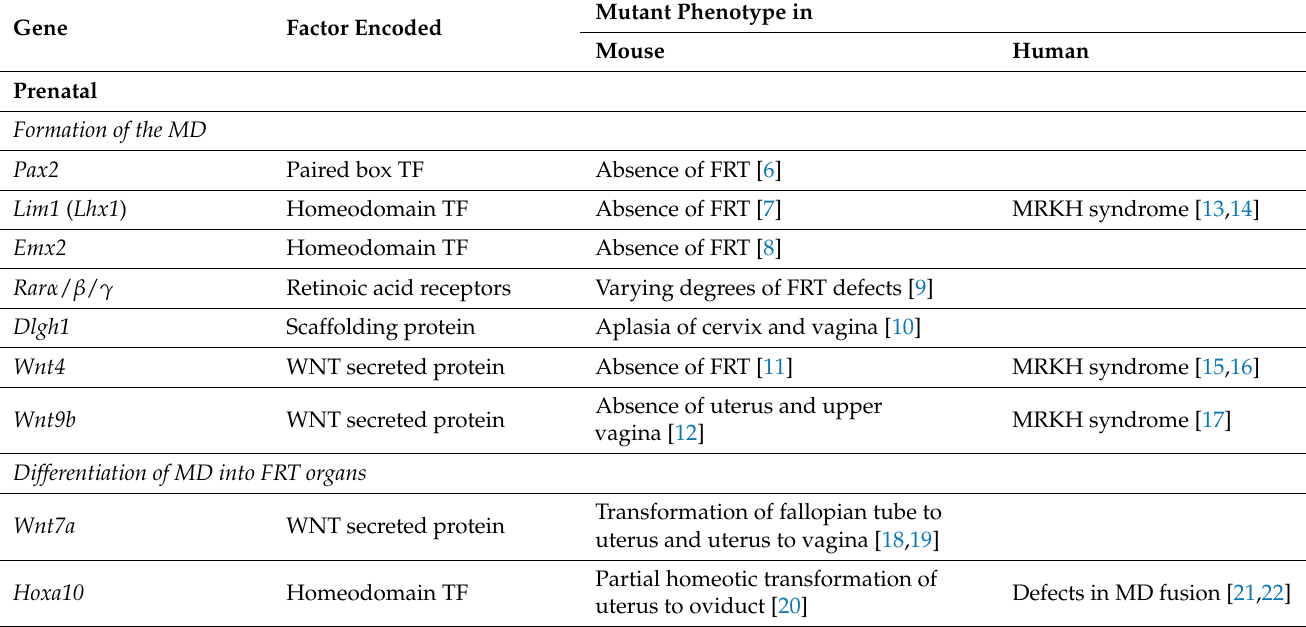
Table 1. Factors involved in endometrium development.